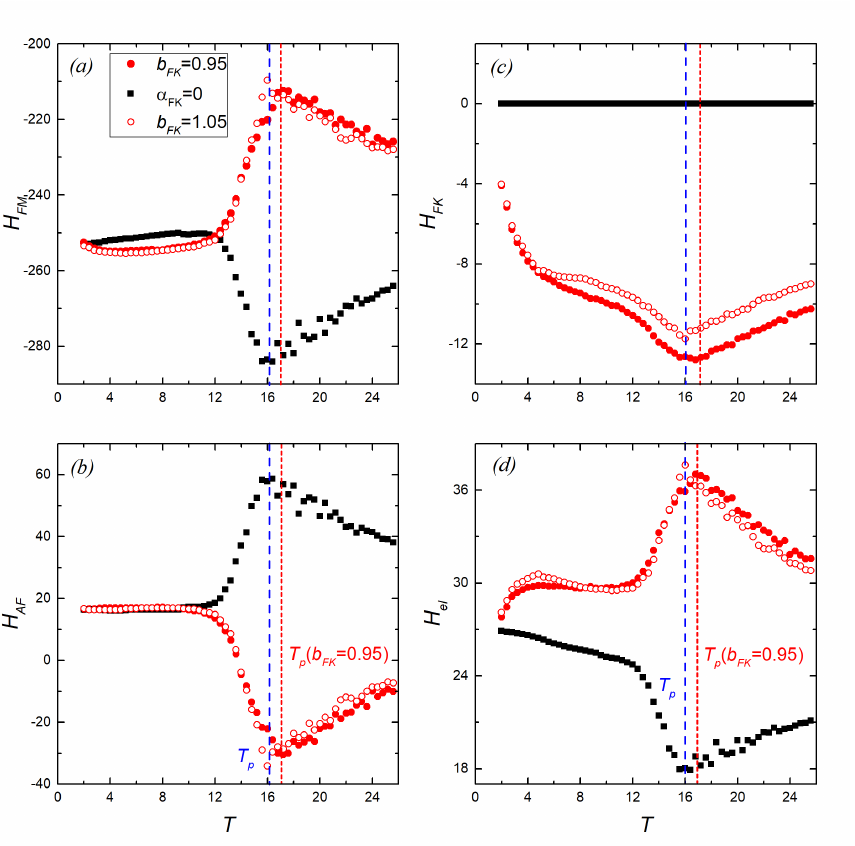
Figure 3. H FM ( a ), H AF ( b ), H FK ( c ), and H el ( d ) as functions of temperature (unit: J FM different periodic substrate potentials ( circles ) and in its absence ( filled squares ). Note that h = 0.6.